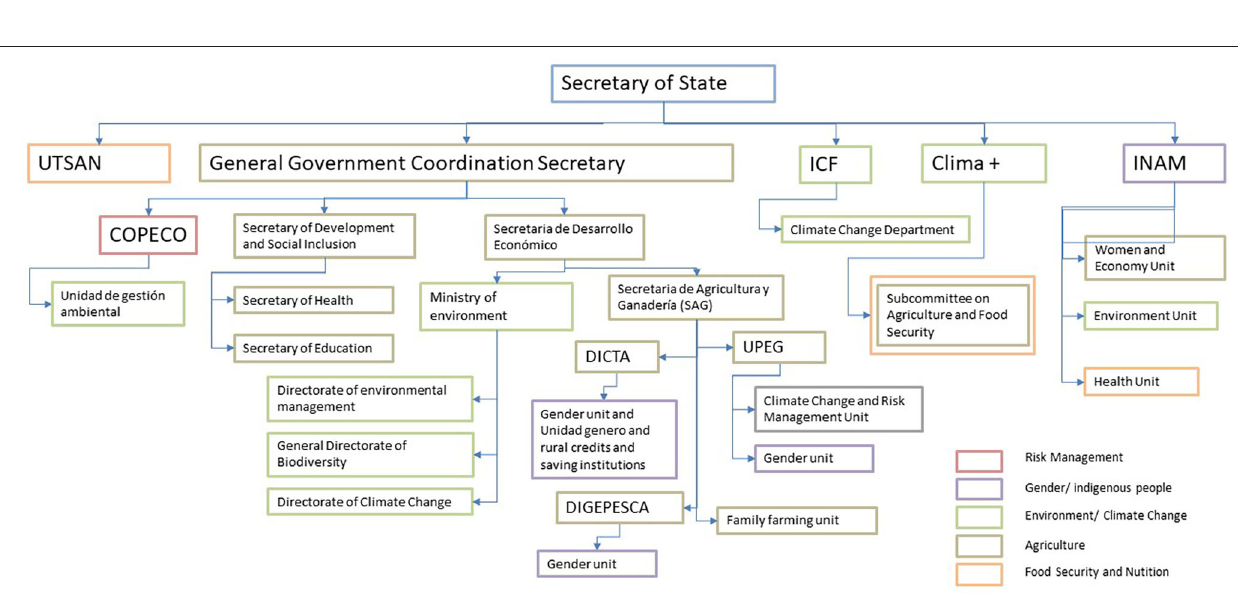
Frontiers in Sustainable Food Systems |